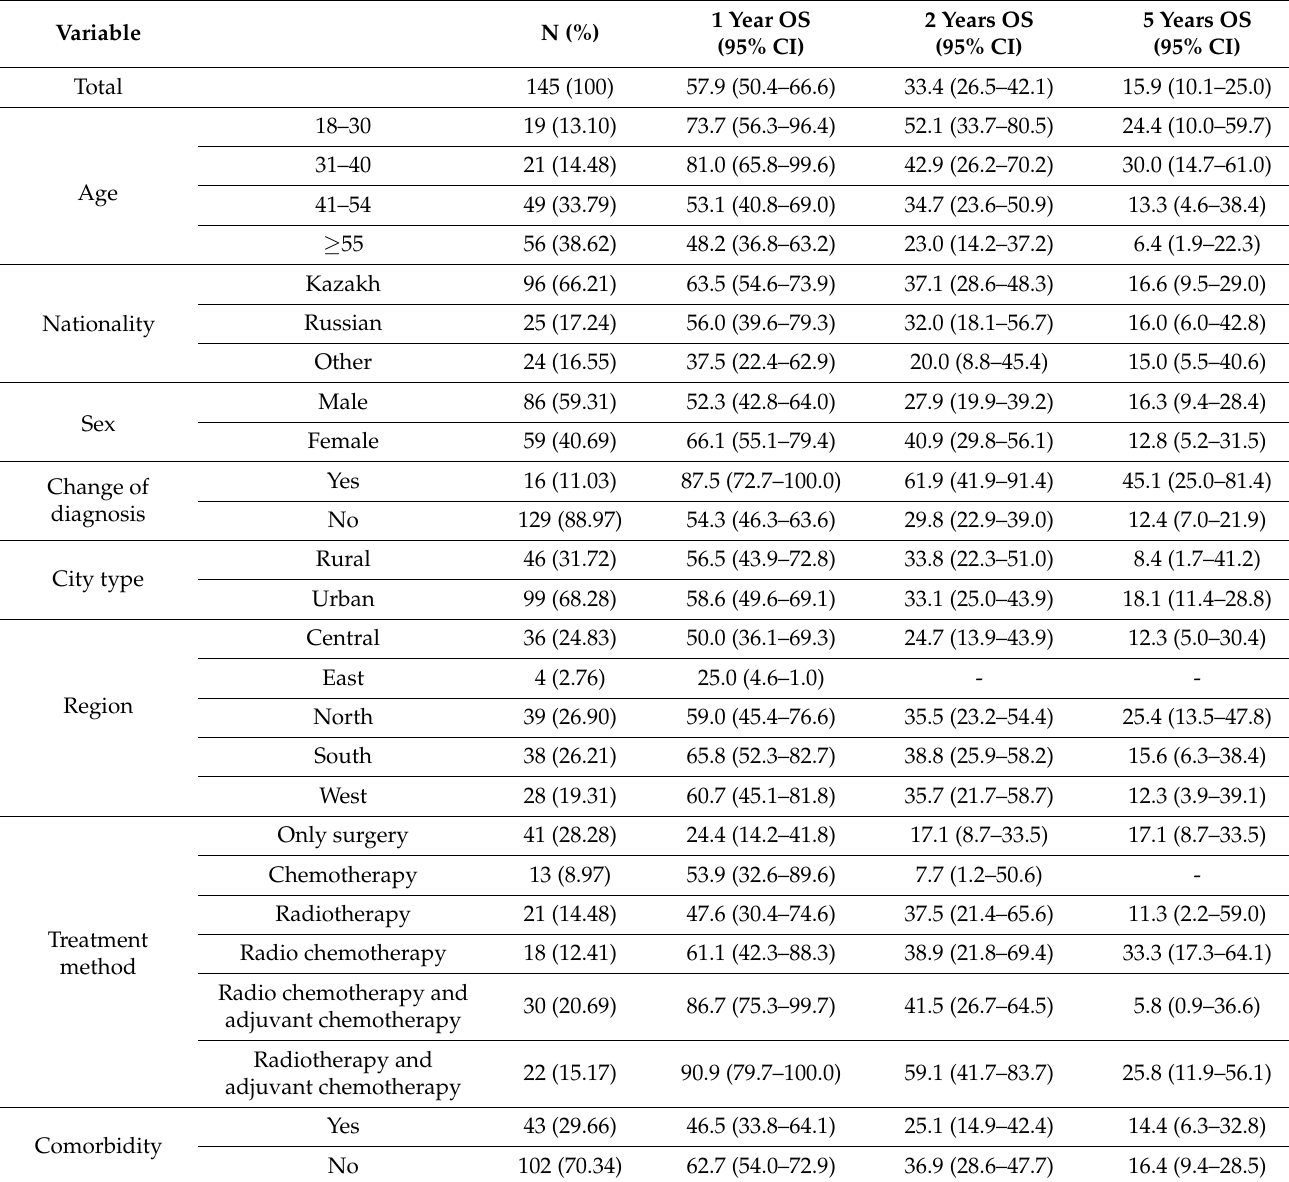
Table 3. Demographic and clinical characteristics of patients with glioblastoma and their